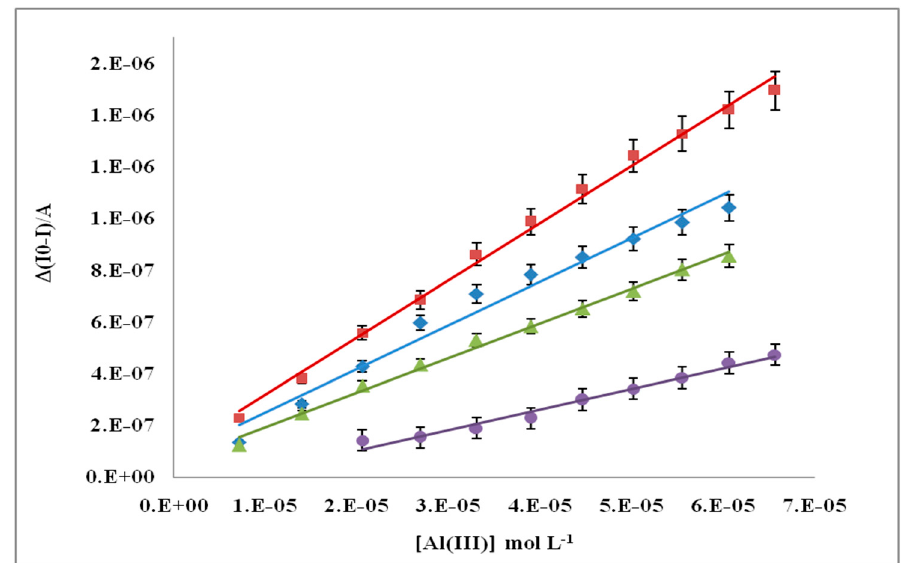
Figure 6. Calibration curves of Al(III) inhibition for ( ■ ) SOD/PdNPs/SPC TTF Es; ( ) SOD/PtNPs/SPC TTF Es; ( ▲ ) SOD/RhNPs/SPC TTF Es and ( ) SOD/AuNPs/SPC TTF Es performed with NPs/SPC TTF Es prepared under CV2 conditions, [EPI] 1.6 × 10 − 4 M, Britton Robinson buffer pH 5.0;Eap = 0.2 V vs. Ag/AgCl.